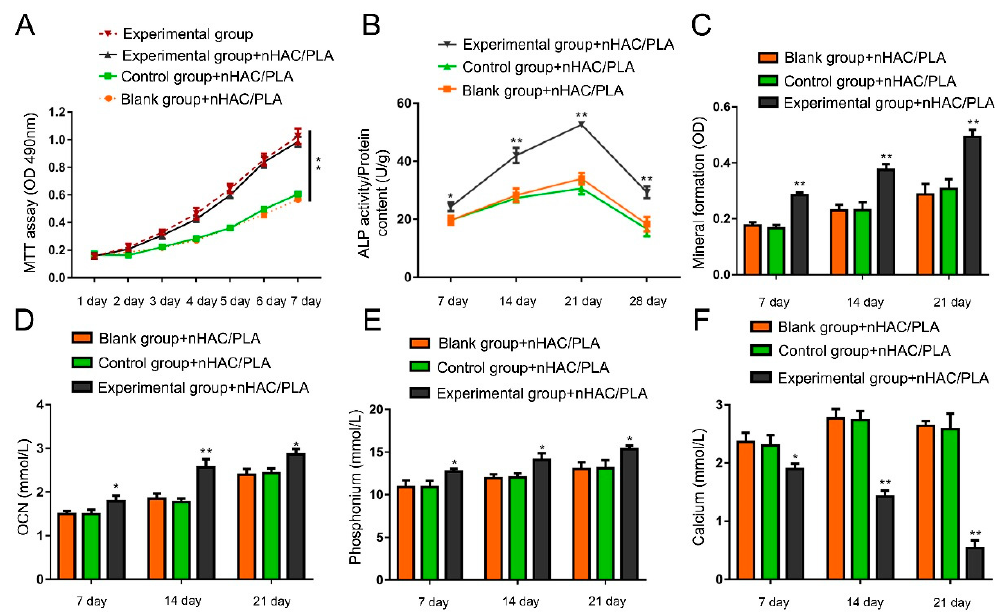
Figure 4. ( A ) Effect of rhBMP-2 on proliferation in the hAMSCs seeded on the nHAC/PLA. The proliferation of the hAMSCs with rhBMP-2 is significantly higher than the cells without rhBMP-2. ( B ) Effect of rhBMP-2 on ALP activity of hAMSCs seeded on nHAC/PLA. ( C ) Effect of rhBMP-2 on mineral formation in the hAMSCs seeded on the nHAC/PLA. ( D – F ) Effect of rhBMP-2 on OCN, phosphate, and calcium content of hAMSCs seeded on nHAC/PLA. ( D , E ) The OCN and phosphate content in the experimental group of hAMSCs on nHAC/PLA were remarkedly higher compared with the control and blank control groups of hAMSCs seeded on nHAC/PLA during the 21 days of culture. ( F ) The calcium content in the experimental group of hAMSCs on nHAC/PLA was significantly lower than the control and blank control groups of hAMSCs on nHAC/PLA during the 21 days of culture. (x ± s, n = 3, * p < 0.05, ** p < 0.01).